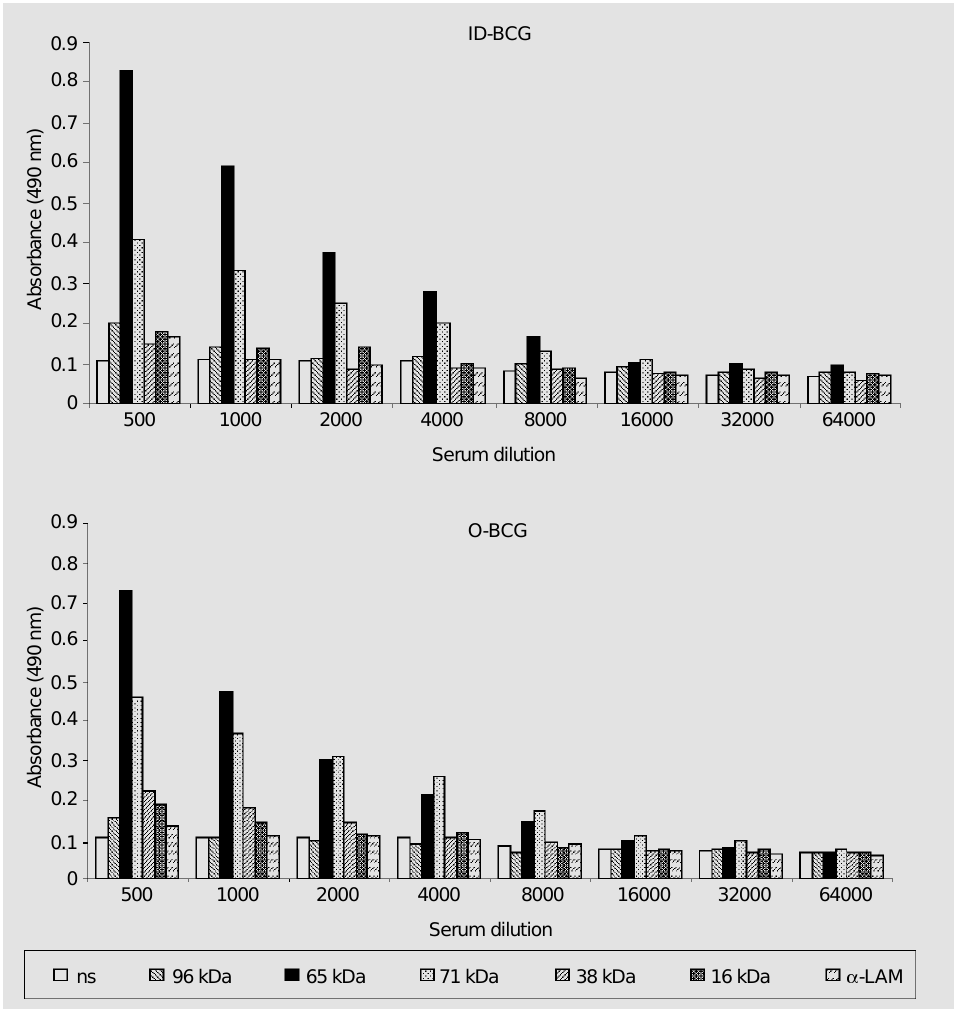
Figure 7 - Anti- Mycobacterium tuberculosis antibodies in sera of mice immunized with 1.5 x 10 6 CFU of O-BCG or ID-BCG. Antibodies against the 96-, 71-, 65-, 38- and 16-kDa proteins or lipoarabinomannan ( a -LAM) from virulent M. tuberculosis were detected by ELISA. Each point represents the mean ± SD of triplicate readings of the sera diluted 1/1000 (O-BCG) or 1/4000 (ID-BCG). ns, Normal